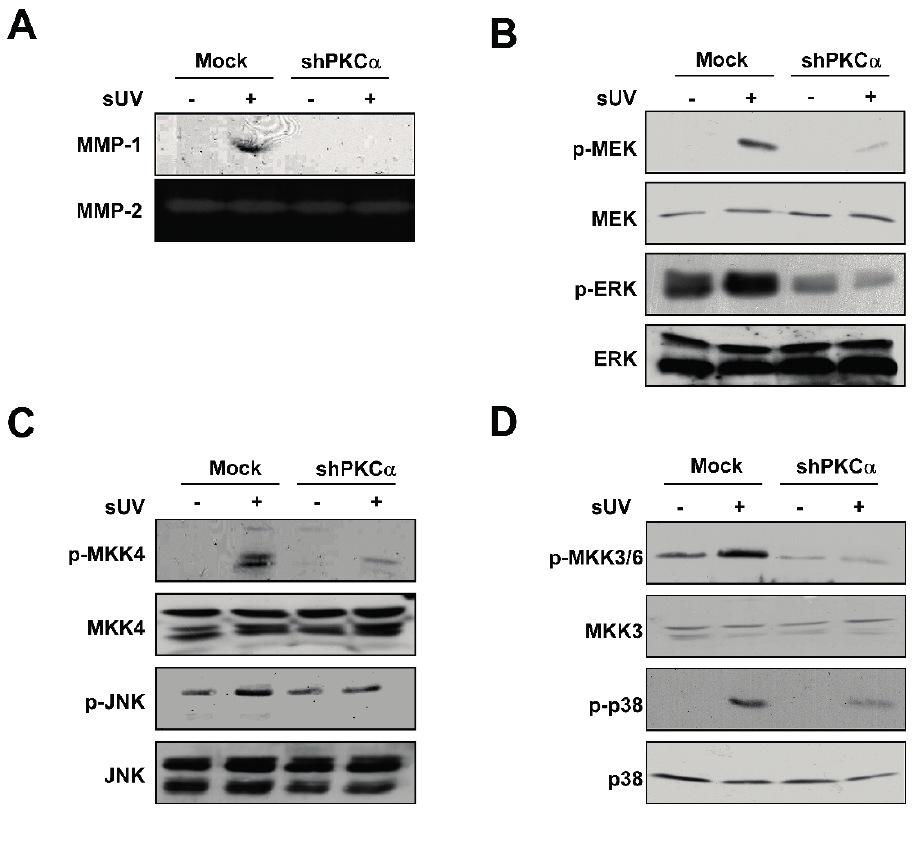
Figure 5. PKC α modulates sUV-induced MMP-1 expression by activation of the MAPK signaling pathway. ( A ) sUV could not induce MMP-1 expression in shPKC α -NHDF cells compared with shMock-NHDF cells. After 48 h of sUV irradiation, the media were collected, and the MMP-1 expression was analyzed using western blot analysis, as described in the Materials and Methods; PKC α regulates the sUV-induced MEK/ERK ( B ), MKK4/JNK ( C ) and MKK3/6/p38 ( D ) signaling pathways. After starvation with serum-free DMEM for 24 h, shMock and shPKC α -NHDF cells were exposed to sUV or not. Then, the protein was harvested after 15 min (p-MEK, p-MKK4 and p-MKK3/6) or 30 min (p-ERK, p-JNK and p-p38). The level of protein was visualized using specific